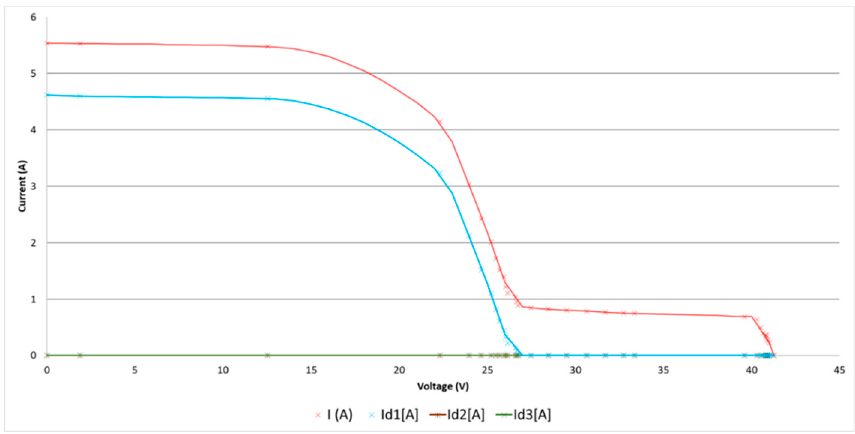
Figure 5. Experimental monocrystalline solar module I–V characteristic curve in condition 2.